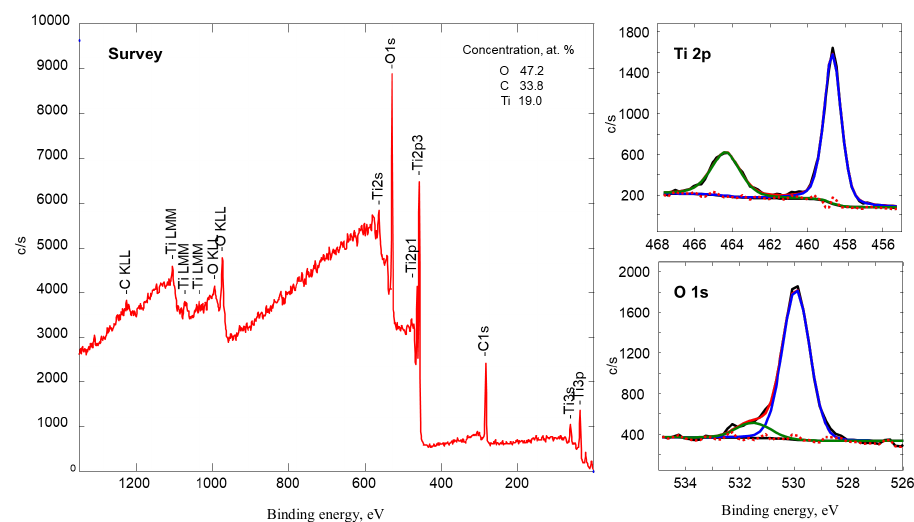
Fig. 2. Survey and high resolution elemental XPS spectra of the as deposited carbon-doped TiO 2 films. XRD crystal structure analysis of magnetron sputter deposited carbon-doped TiO 2 films (Fig. 3) showed that films consisted of preferentially oriented anatase (metastable phase) and rutile (the most stable TiO 2 form) phase mixture.